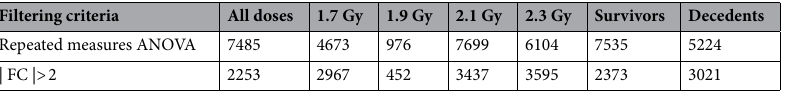
Table 1. Stepwise summary of the microarray data. Data were analyzed along all doses together, and at each dose and survivors and decedents separately. Repeated measure ANOVA and Benjamini Hochberg correction were applied for each variable. Data were further filtered based on ‘Present’ Flags in at least one condition; absolute fold change cut-off was set at 2.